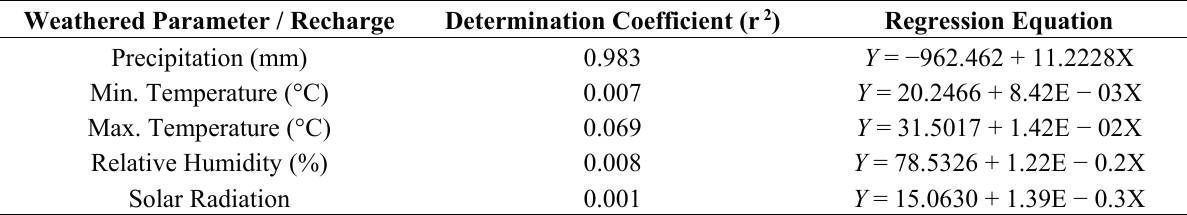
Table 6. Regression analysis of weather parameters on estimated